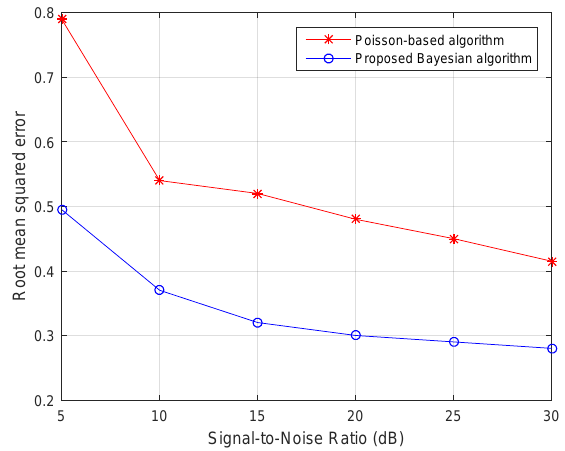
Figure 4. Root mean squared error (RMSE) curves of the Poisson-based MAP algorithm and the proposed sparse Bayesian